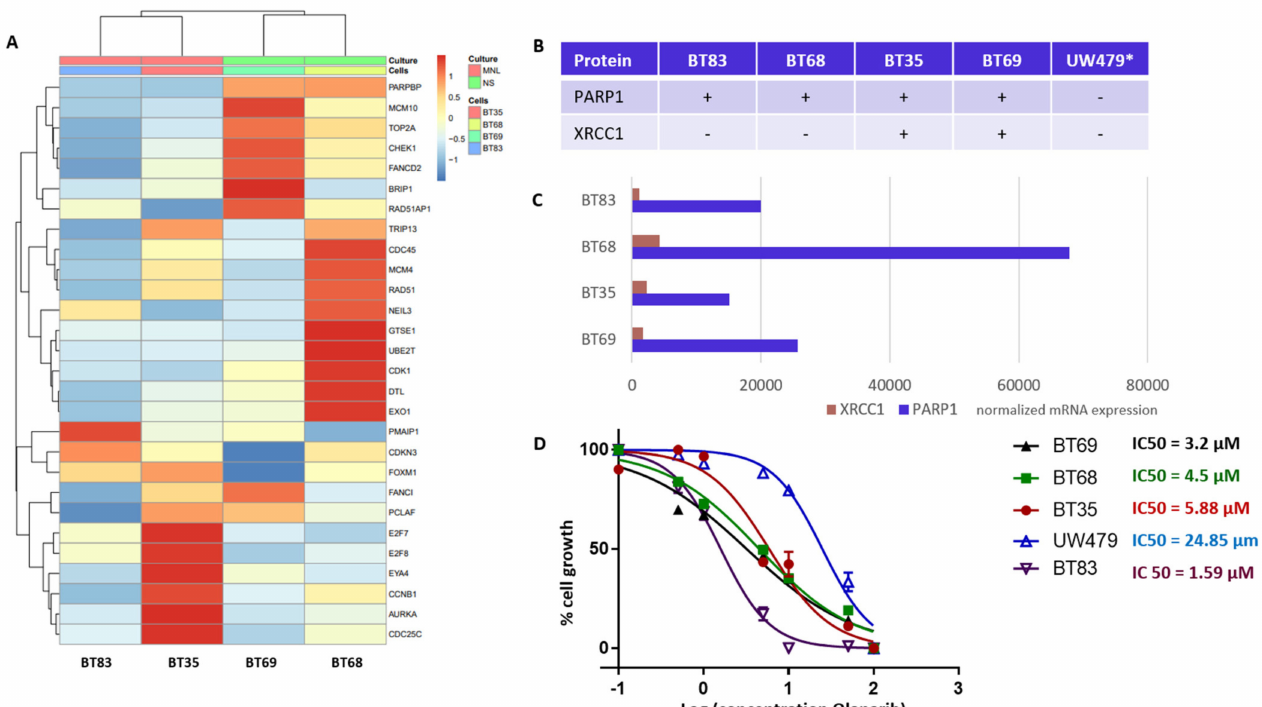
Figure 6. DNA repair and cell cycle gene deregulation studied in patient-derived cell lines (PDCL) and PARP1 functional inhibition. ( A ) Heatmap of standardized gene expression for BT83, BT35, BT69, and BT68 cell lines, based on the pHGG gene signature. ( B ) Basal levels of protein expression detected by immunohistochemical analyses in the PDCL paired tumors and in the UW479 cell line (*, based on previous publication [30]) in absence of Olaparib treatment. ( C ) Normalized mRNA expression levels of XRCC1 and PARP1 in each cell line in the absence of Olaparib, as assessed by RNA sequencing. ( D ) Response of each cell line to Olaparib as determined by a 96 h growth assay, and related IC50